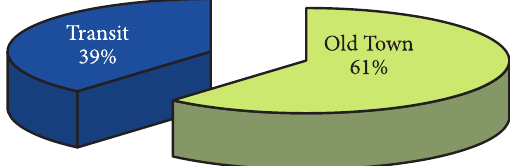
fig. 5. Transit traffic in Vilnius Old Town